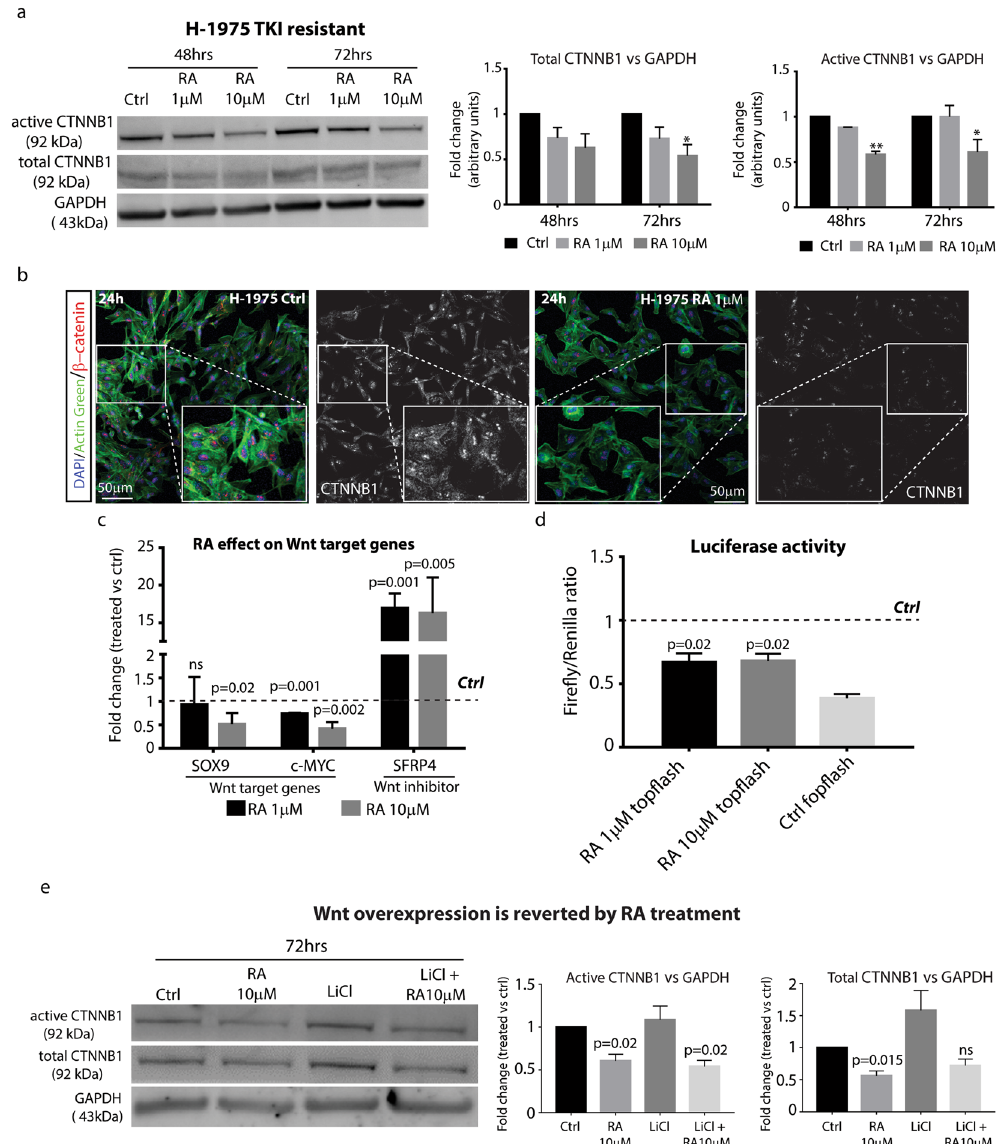
Figure 4. Wnt signaling activation is inhibited by RA in TKI resistant NSCLC cell line. (a) Left panel, representative Western Blotting analysis of total and active-CTNNB1 in H-1975 treated with 1 and 10 µ M RA for 48 and 72 hrs (n = 3). Right panel, densitometric analysis of total and active-CTNNB1 protein levels in H-1975 cells upon RA treatment for 48 and 72 hrs. The analysis has been performed by using GAPDH as normalizer loading control (n = 3) ( * = 0.02, ** = 0.05). (b) Immunofluorescence staining of CTNNB1 in H-1975 cells treated with or not with 1 µ M RA for 24 hrs (see also insets for all the experimental conditions). Cells are counterstained with Actingreen 488 (green label) and nuclei are marked in blue with DAPI (scale bar 50 µ m, n = 3). (c) qRT-PCR analysis of Wnt target genes and the Wnt inhibitor SFRP4 in H-1975 cells treated with 1 and 10 µ M RA for 48 hrs. The comparison has been conducted by using the ΔΔ CT method and normalized to GAPDH transcript. Dotted line represents the normalized expression levels of each transcript analyzed in untreated cells. Data are represented as mean ± SD. Statistical analysis has been obtained by unpaired t test (n = 3). (d) Luciferase assay of H-1975 cells transfected with Wnt reporters TOPFlash/FOPFlash and treated with 1 and 10 µ M RA for 48 hrs. Data are represented as mean ± SD. The histograms represent the value obtained by calculating the Firefly/Renilla ratio, the latter used to measure transfection efficiency. Dotted line represents the normalized expression levels of luciferase activity in H-1975 untreated cells. Statistical analysis has been obtained by unpaired t-test (n = 3). (e) Representative Western Blotting analysis of total and active-CTNNB1 protein levels in H-1975 cells treated with 10 µ M RA, 2.5 mM LiCl or co-treated (10 µ M RA + 2.5 mM LiCl) for 72 hrs and its relative densitometric analysis (central and right panel). The analysis has been performed by using GAPDH as normalizer loading control (n =